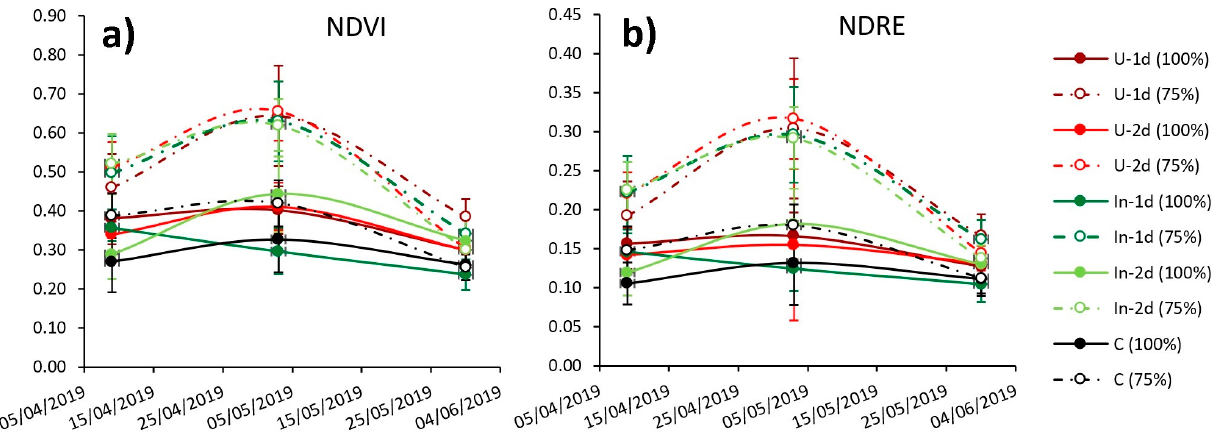
Figure 4. ( a ) NDVI and ( b ) NDRE indexes estimated with the RapidScan® in the different treatments along the wheat cycle. Bars represent the standard error. Treatments were a combination of urease inhibitor use (In), simple urea use (U), or no fertilizer (C), with fertilizer application in one (1 d) or two (2 d) dressings and optimally irrigated (100%) or sub-optimally irrigated (75%).